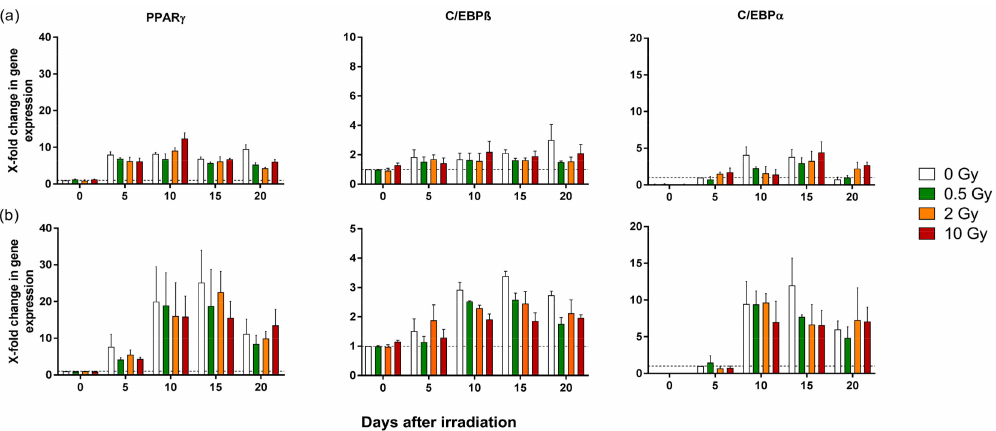
Figure 5. Gene expression of transcription factors in human adipocytes. ( a ) Human primary pre-adipocytes and ( b ) SGBS pre-adipocytes were irradiated with 0.5, 2, and 10 Gy X-rays and differentiation was initiated. Gene expression of PPAR γ , C/EBP β , and C/EBP α was analyzed on the indicated days using quantitative polymerase chain reaction qPCR. The data are normalized to GAPDH gene expression and to the gene expression on day 0 (for PPAR γ and C/EBP β ) or on day 5 (for C/EBP α ). The X-axis represents days after irradiation and the Y-axis is the relative fold change in gene expression. Mean, SEM. N =